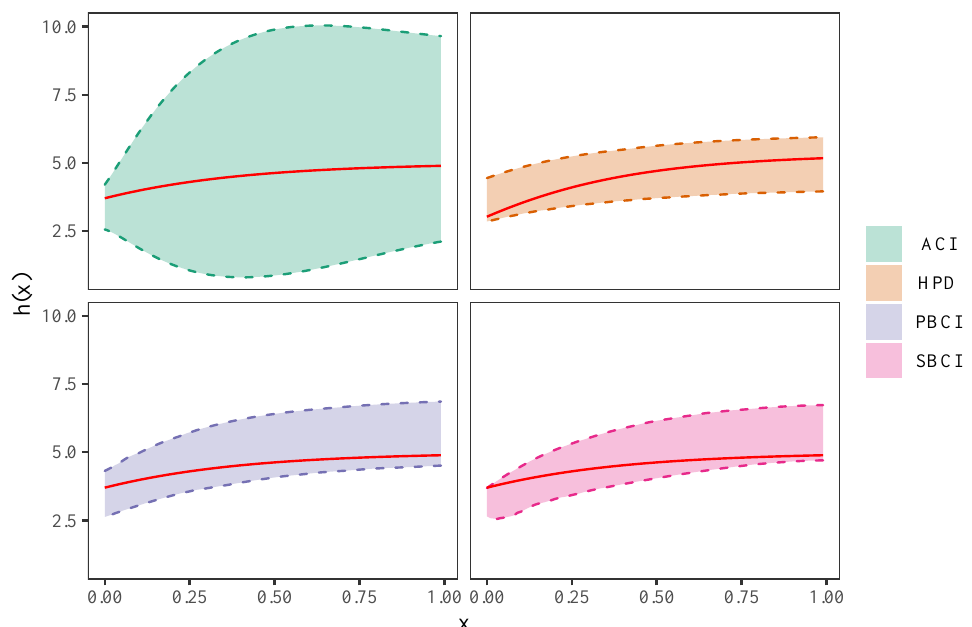
Figure 5. Interval estimates of HRF h ( x ) where the true values of h ( x ) are marked in red.